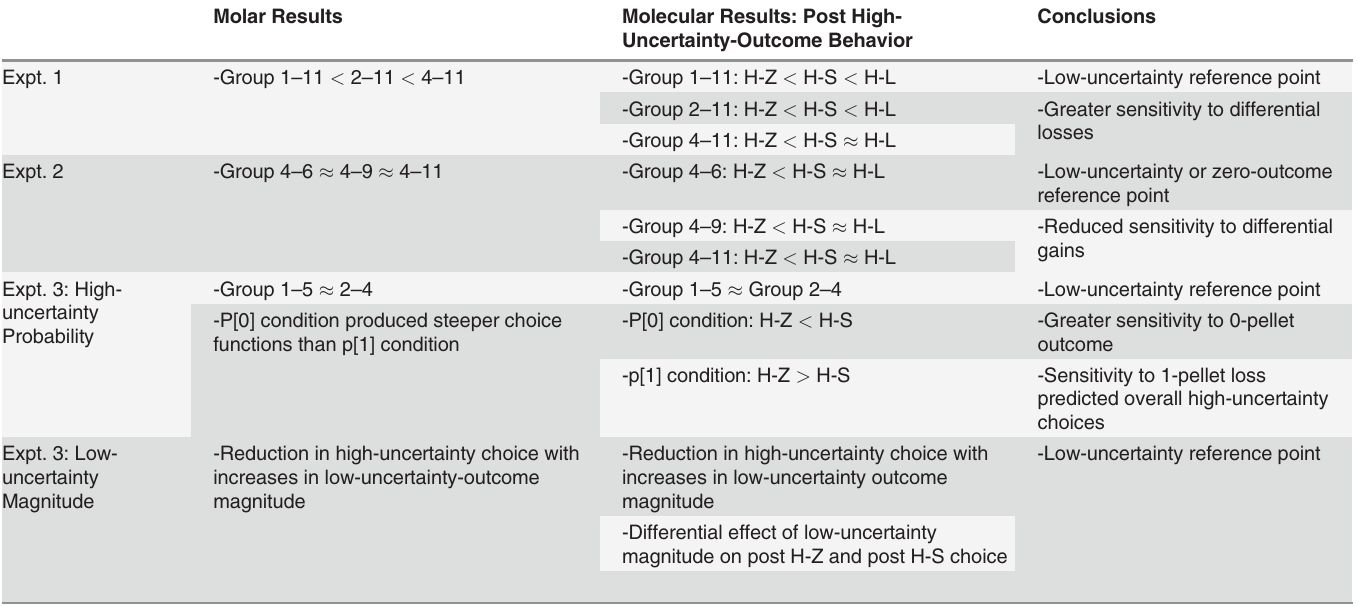
Table 4. Summary of the primary results from Experiments 1 –